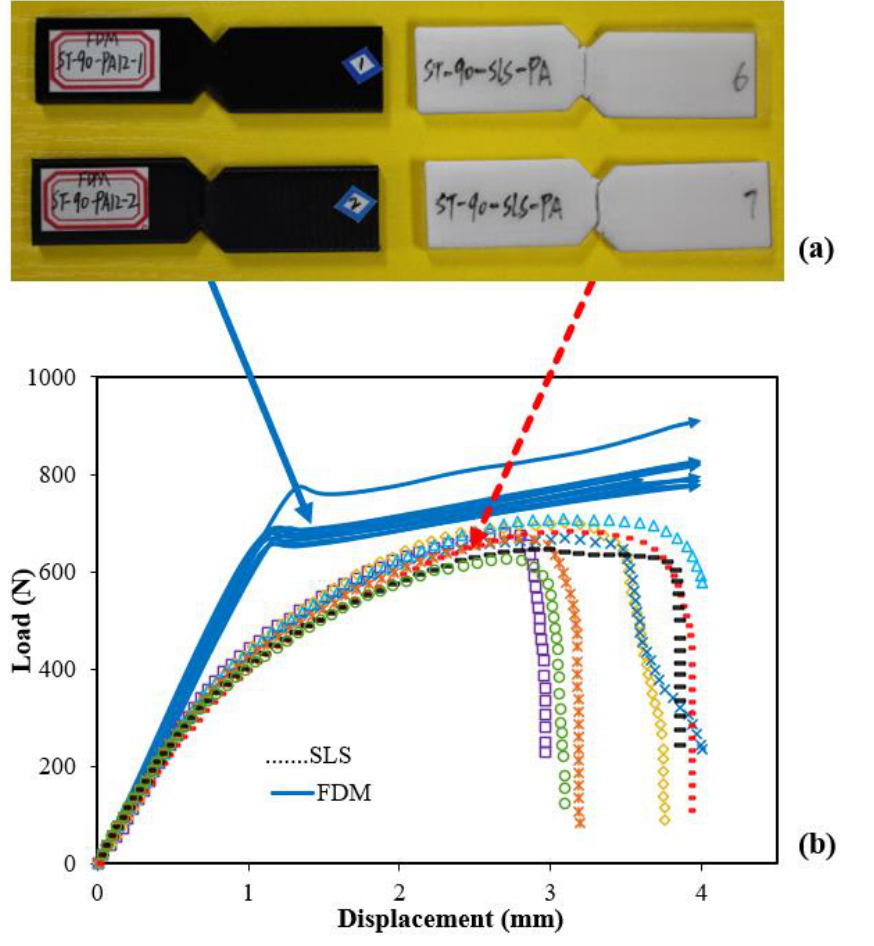
Figure 3. ( a ) Very different shear failure patterns and ( b ) loading processes of PA specimens made with FDM (black specimens, no fracture) and SLS (white specimens, shear fracture).